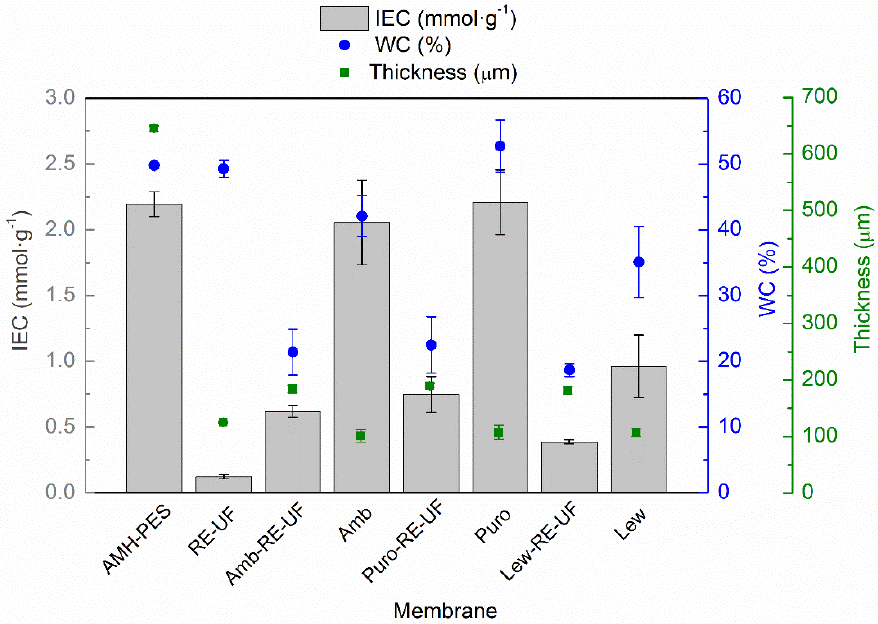
Figure 3. Ion exchange capacity (IEC, mmol · g − 1 ); water content (WC, %) and thickness ( µ m) of the studied membranes.